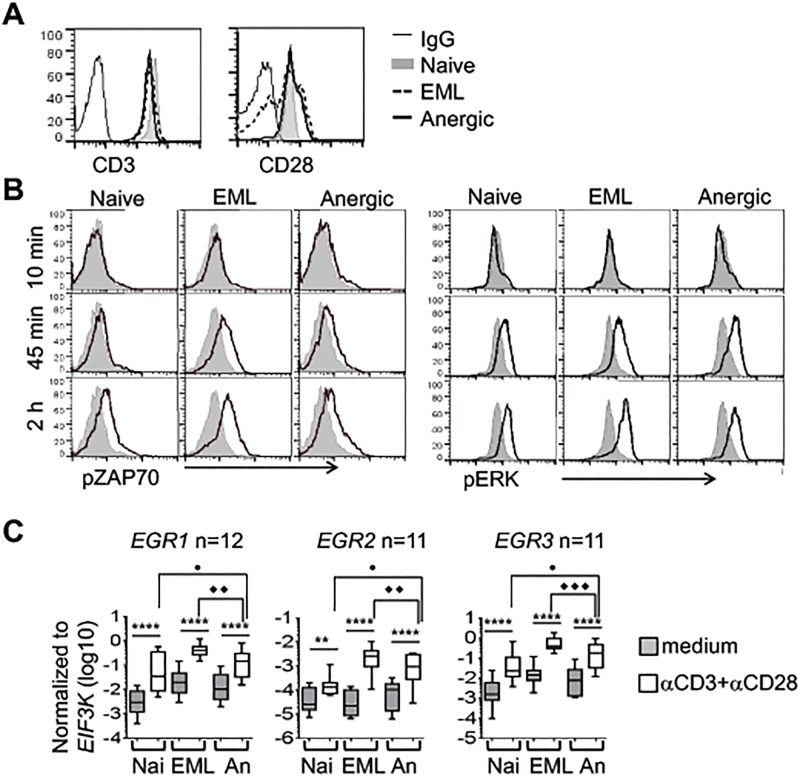
Anergic cells can receive TCR signaling.Naïve cells were activated to generate effector or anergic cells as in Fig 1 and rested for 4–5 days. A. The surface expression of CD3e and CD28 was analyzed by FACS. B. The phosphorylation of ZAP70 (left panel) and ERK1/2 (right panel) was measured in unstimulated (gray plot) and αCD3 + αCD28–stimulated (solid line) naïve, effector/memory-like (EML), and anergic cells at the indicated time points. Shown is one representative experiment out of 4 independent experiments. C. Rested cells were not activated or were activated with soluble αCD3 + αCD28 for 4 hours. mRNA expression of the indicated genes was measured by qRT-PCR (Box and whiskers plot). The data are presented as mean ± SEM (*p<0.05, **p<0.01, ***p<0.001, ****p<0.0001). An, anergic cells; EML, effector/memory-like T cells; Nai, naïve cells.